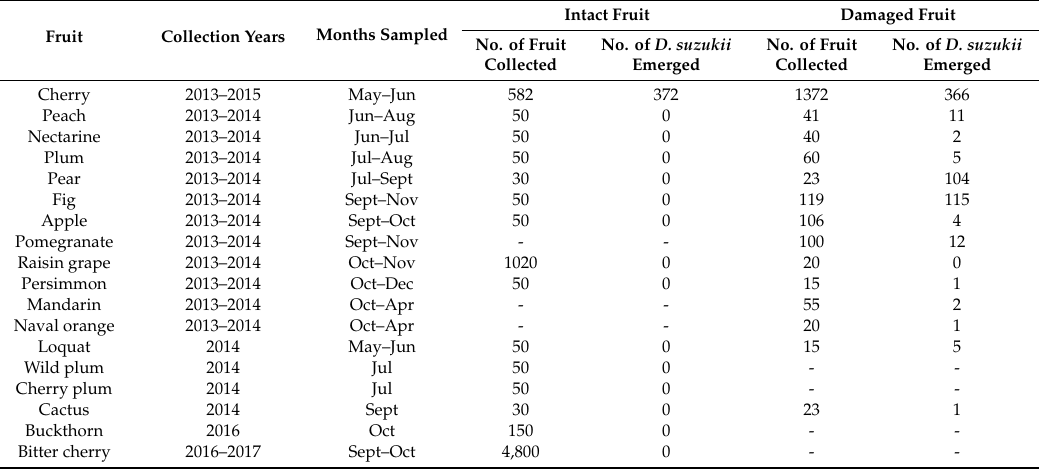
Table 2. Drosophila suzukii emerged from fruits in the San Joaquin Valley, CA,